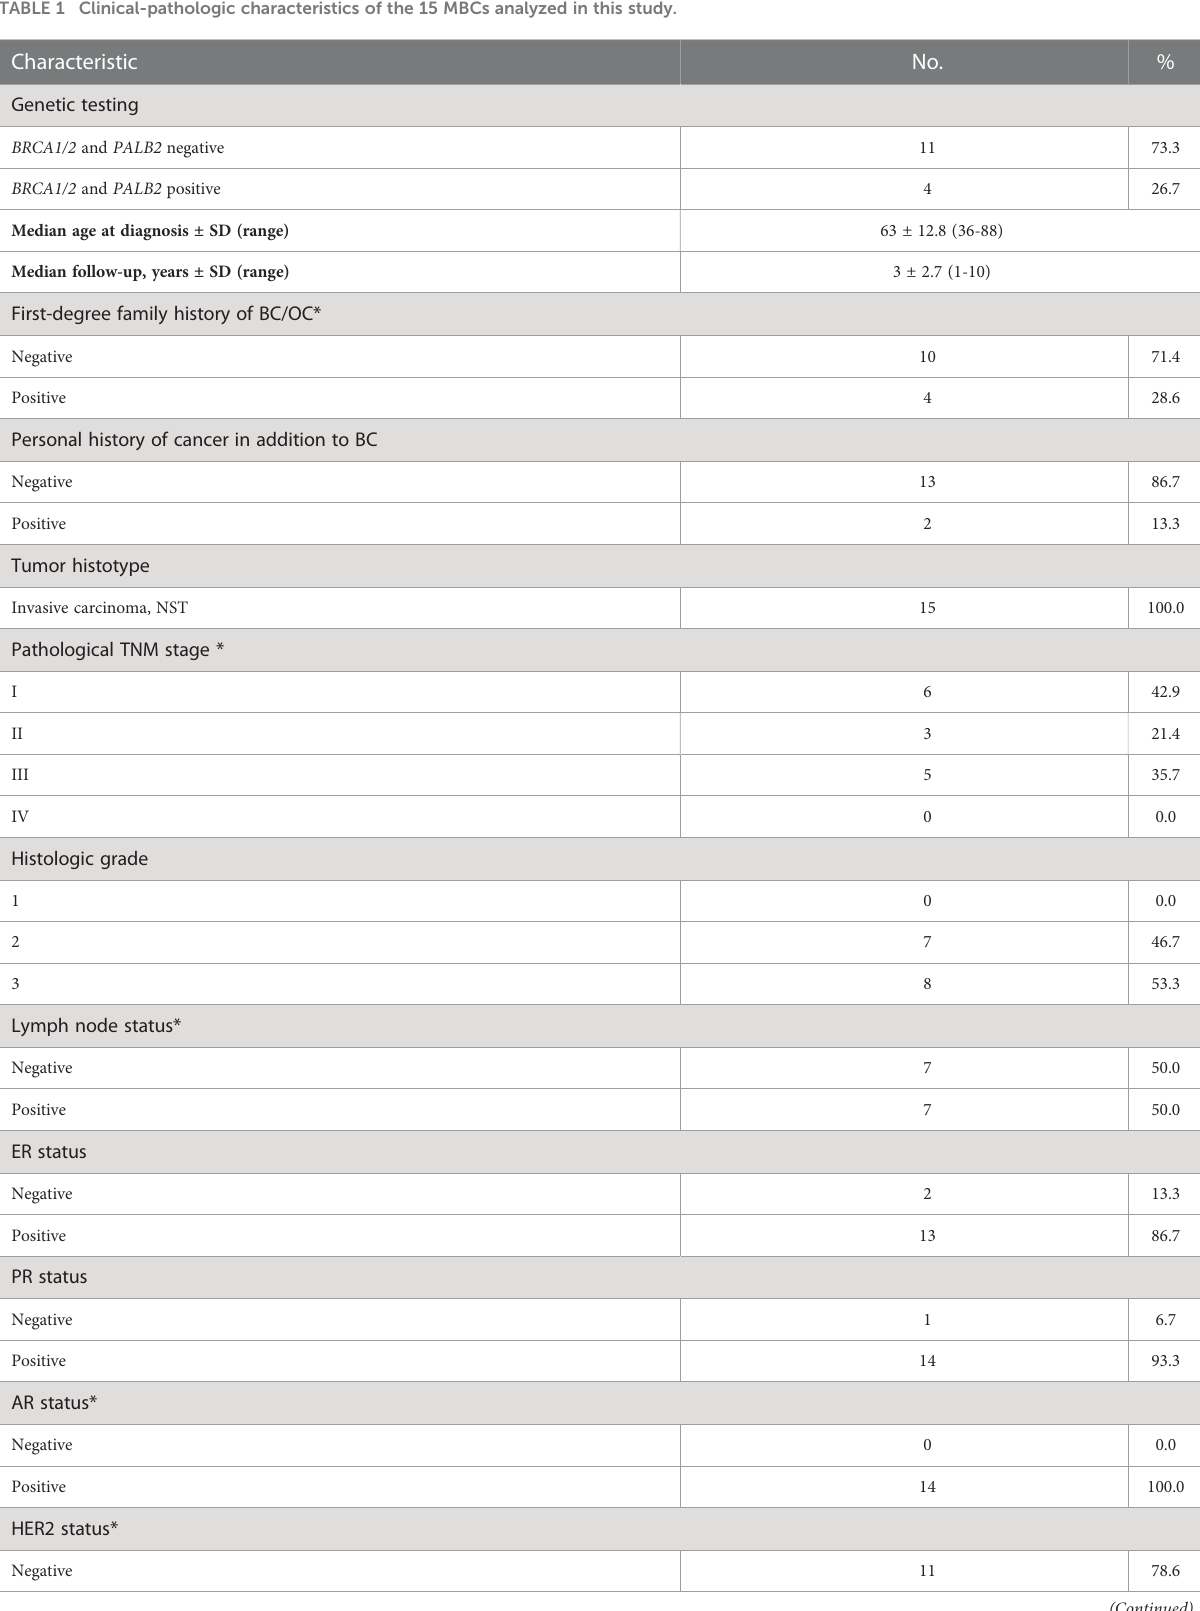
TABLE 1 Clinical-pathologic characteristics of the 15 MBCs analyzed in this study. Characteristic No. % Genetic testing BRCA1/2 and PALB2 negative 11 73.3 BRCA1/2 and PALB2 positive Median age at diagnosis ± SD (range) Median follow-up, years ± SD